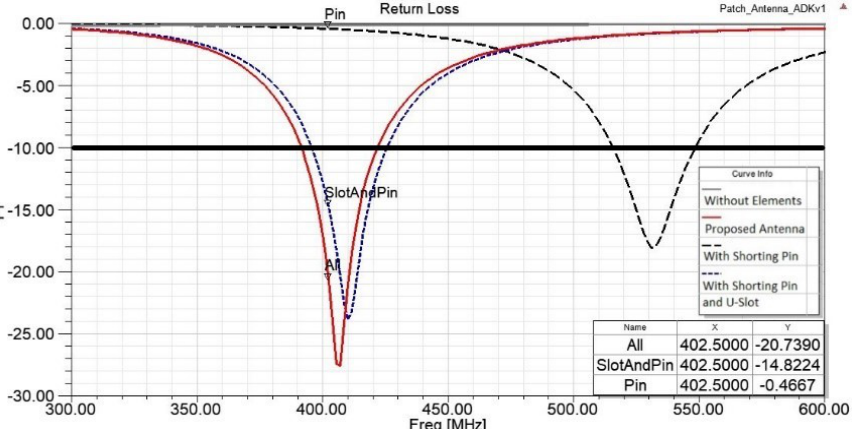
Figure 4. Reflection coefficient after antenna structure modifications in the MedRadio band in the pancreas model.